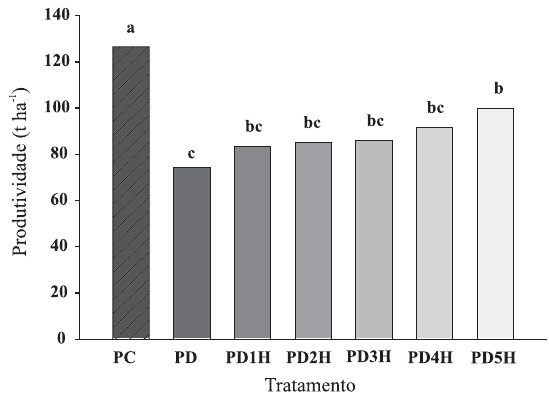
Figura 1. Produtividade de melancia em diferentes